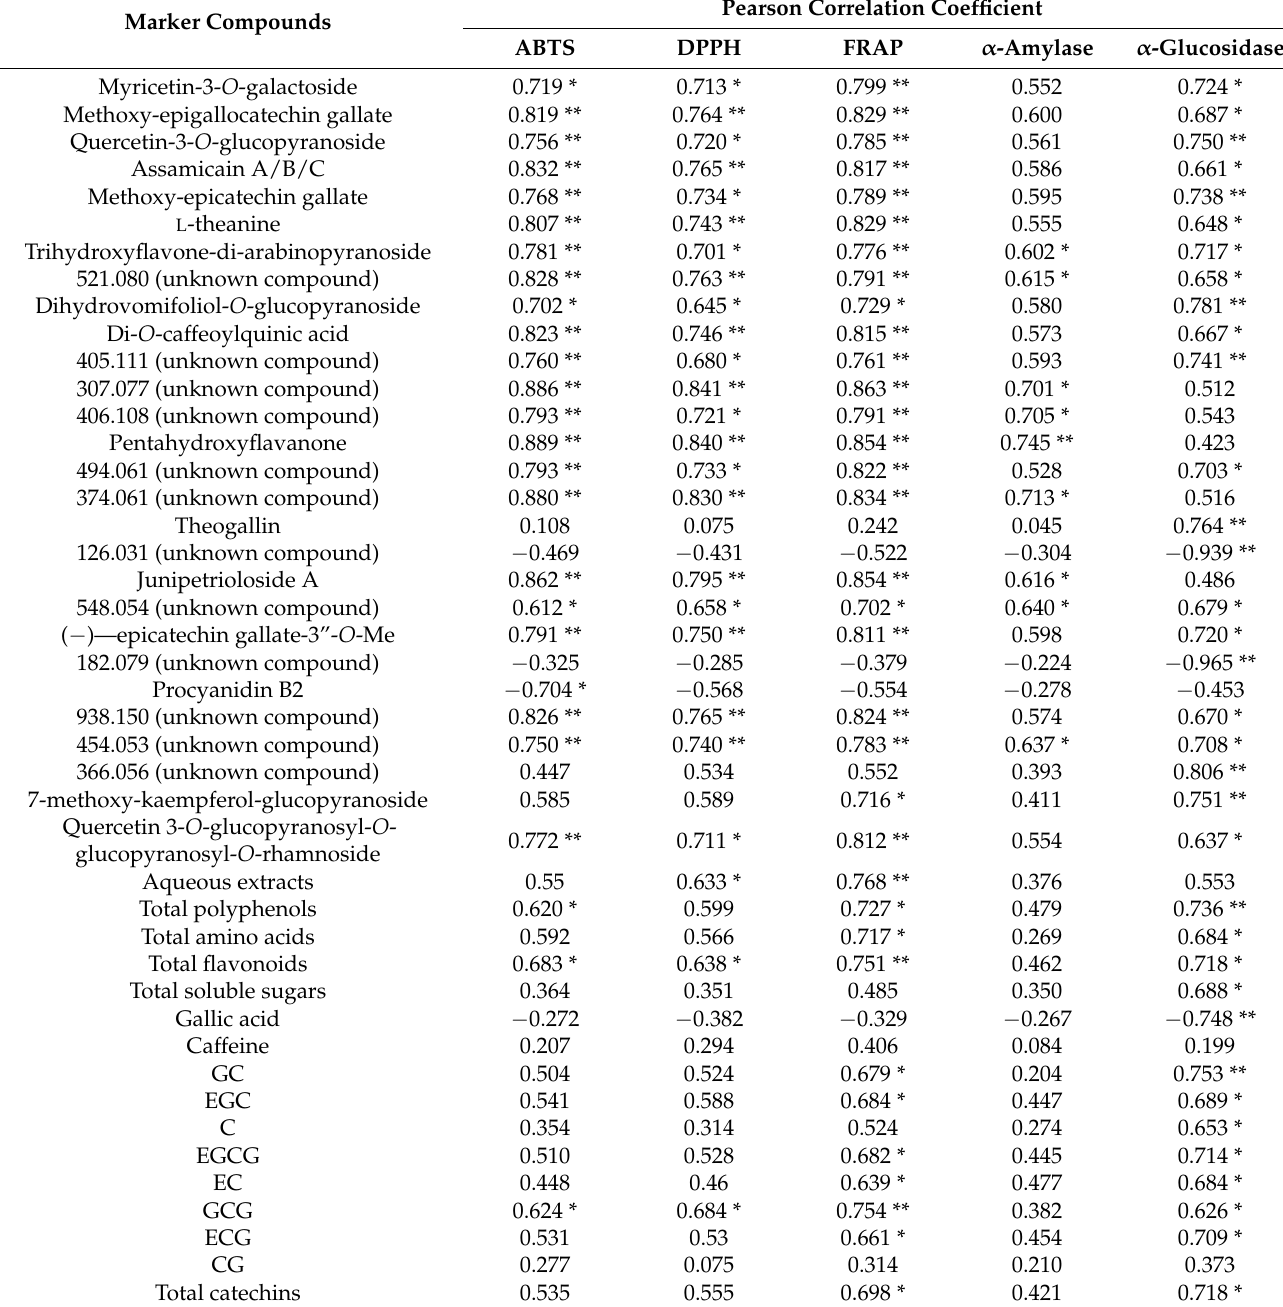
Table 4. Pearson correlation coefficients between chemical compositions and biological